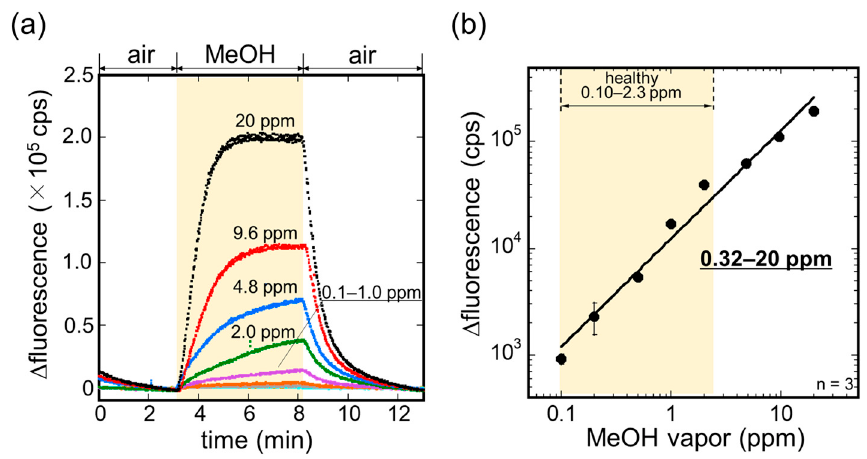
Figure 5. ( a ) Sensor outputs to various concentrations of MeOH vapor. ( b ) A calibration curve of the bio-sniffer to MeOH vapor.